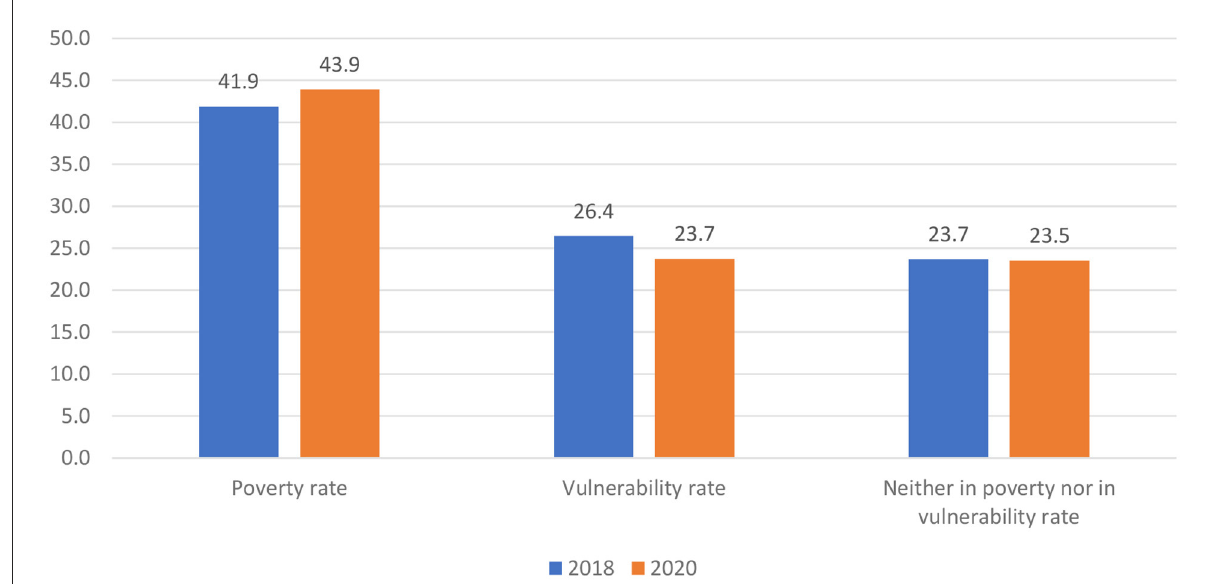
FIGURE4 Changes in poverty structure of Mexican population, 2018–2020 (%). Source: Based on data published by the Mexican National Commission for the Evaluation of Social Development